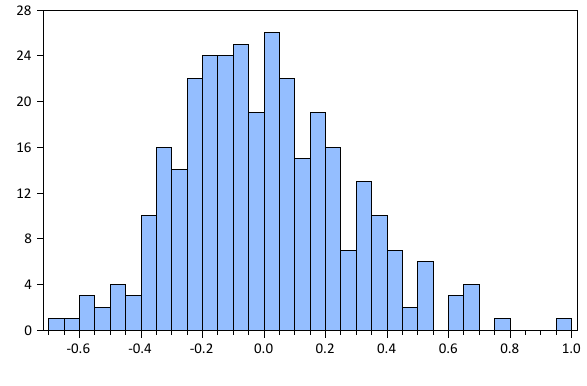
Figure 1. Normality test